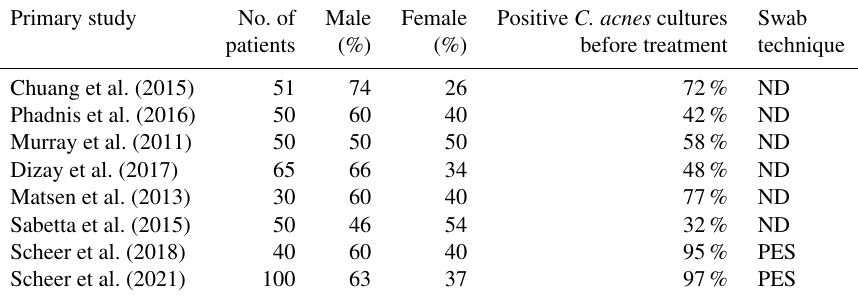
Table 3. Positive C. acnes cultures in different studies. Primary study No. of Positive C. acnes cultures